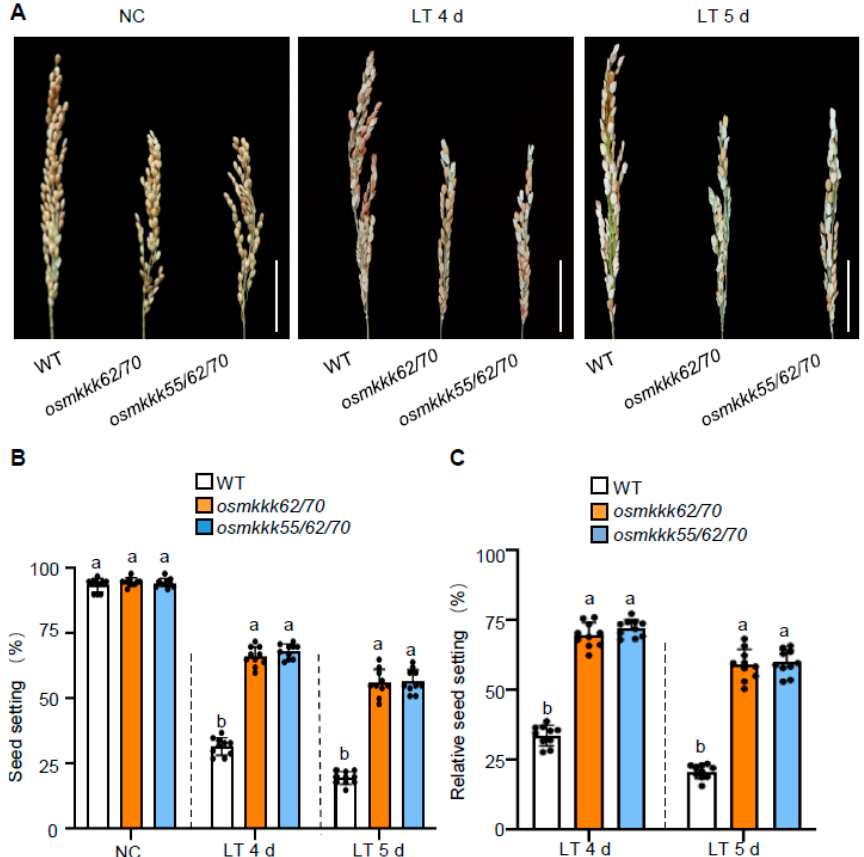
Figure 2. osmkkk62/70 and osmkkk55/62/70 mutants show increased cold tolerance at booting stage. ( A ) Representative images of panicles of WT, osmkkk62/70, and osmkkk55/62/70 mutants grown under NC, and after LT treatment for 4 or 5 days. The scale bars are 5 cm. ( B , C ) Seed setting rate ( B ) and relative seed setting rate ( C ) of WT, osmkkk62/70, and osmkkk55/62/70 mutants grown under NC, and after LT treatment for 4 or 5 days. Data are shown as means ± SE (n = 10). Dotted lines were drawn to separate the NC and LT, and the comparison is among different genotypes in the same condition. Each dot represents the result from one biological replicate; error bars indicate means ± SE. Statistically significant differences are indicated by different lowercase letters ( p < 0.05, one-way ANOVA with Tukey’s significant difference test).